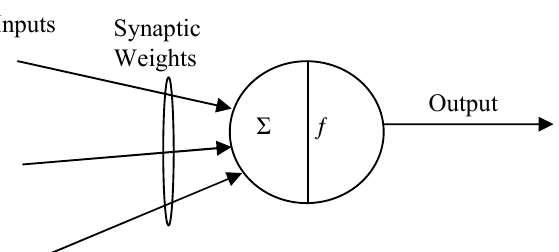
Figure 2: The first synthetic neuron in the early 1940s (McCullock and